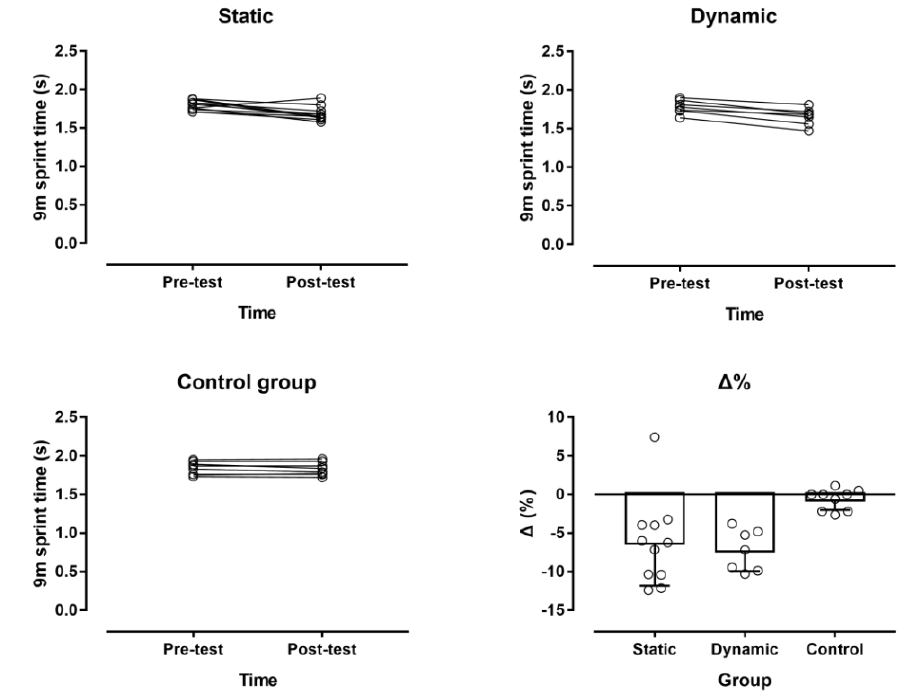
Figure 5. Individual changes in the 9 m sprint time by experimental group and percentage change (Δ%).